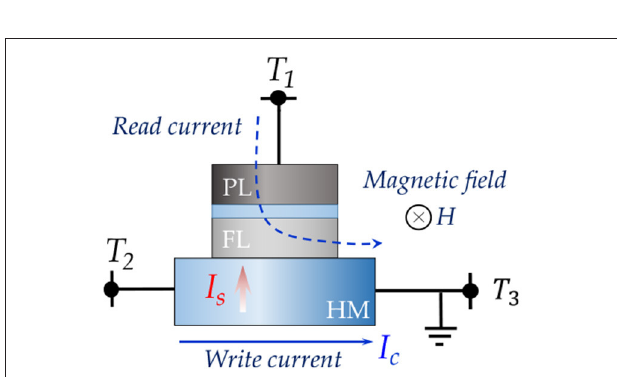
FIGURE 2 | Spin-orbit torque device undergoes oscillation due to applied external magnetic field, H , and charge current, I c . Note that the directions of both the magnetic field and magnetic anisotropy are